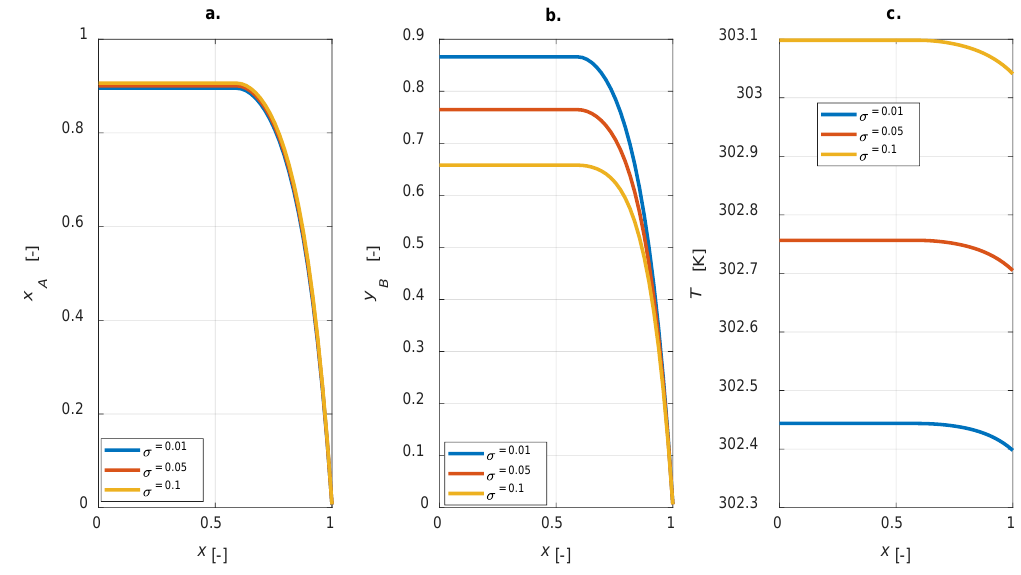
Figure 6. Intraparticle profiles computed varying the ratio between the kinetic constants at the reference temperature of reactions 2 and 1 for the egg-shell catalyst: ( a ) A conversion; ( b ) yield to B; ( c ) temperature.